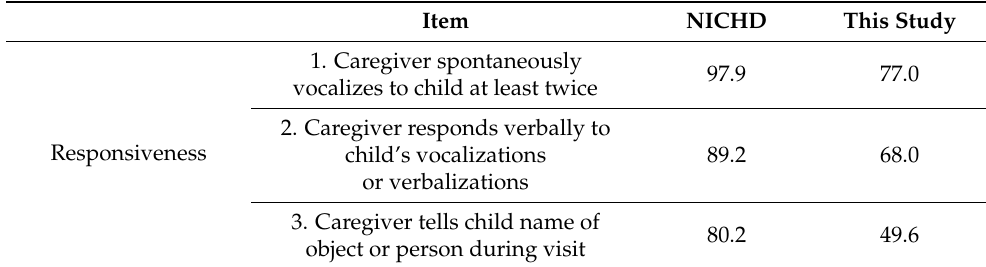
Table A1. Infant-Toddler Child Care HOME Inventory with pass